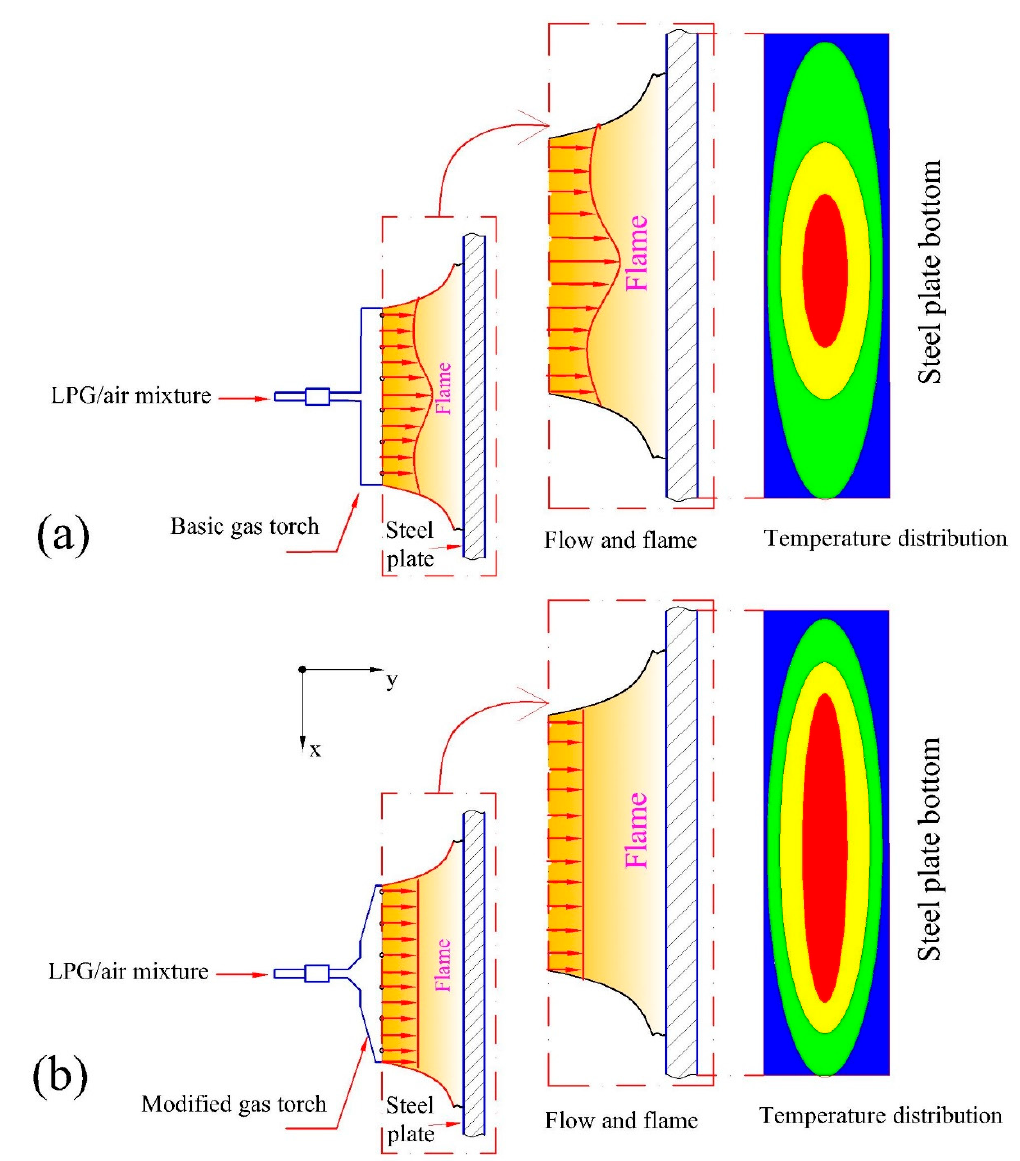
Figure 1. Comparison of typical flow field and temperature distribution of a steel plate: ( a ) basic gas torch; ( b ) modified gas torch.